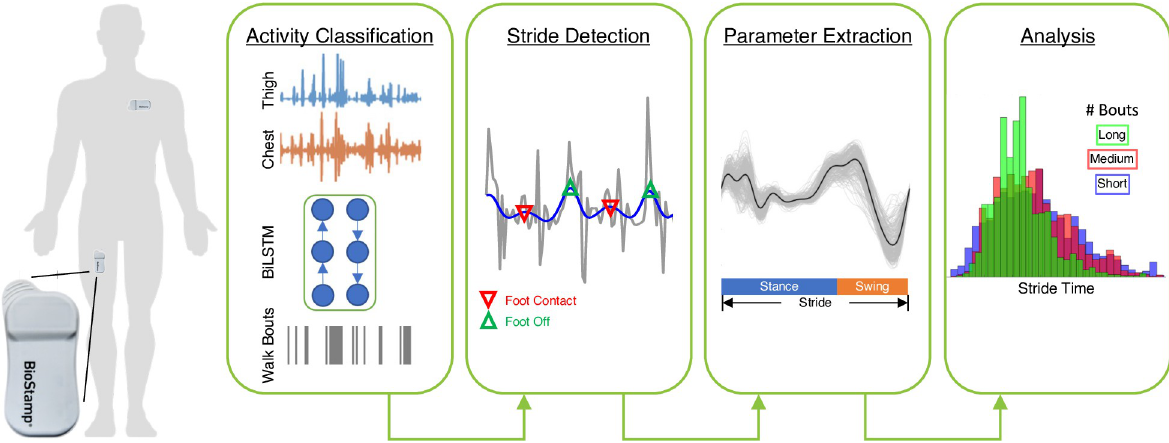
Fig 1. Pipeline for free-living gait analysis from BioStamp nPoint wearable sensor data. Activity classification is performed via deep neural network (BiLSTM architecture) on windows of accelerometer data sampled from the chest and thigh. Walking bouts are extracted from the resulting activity timeseries and gait events are identified using previously validated approaches to detect strides. Gait parameters are extracted from each walking bout and used for further analysis.